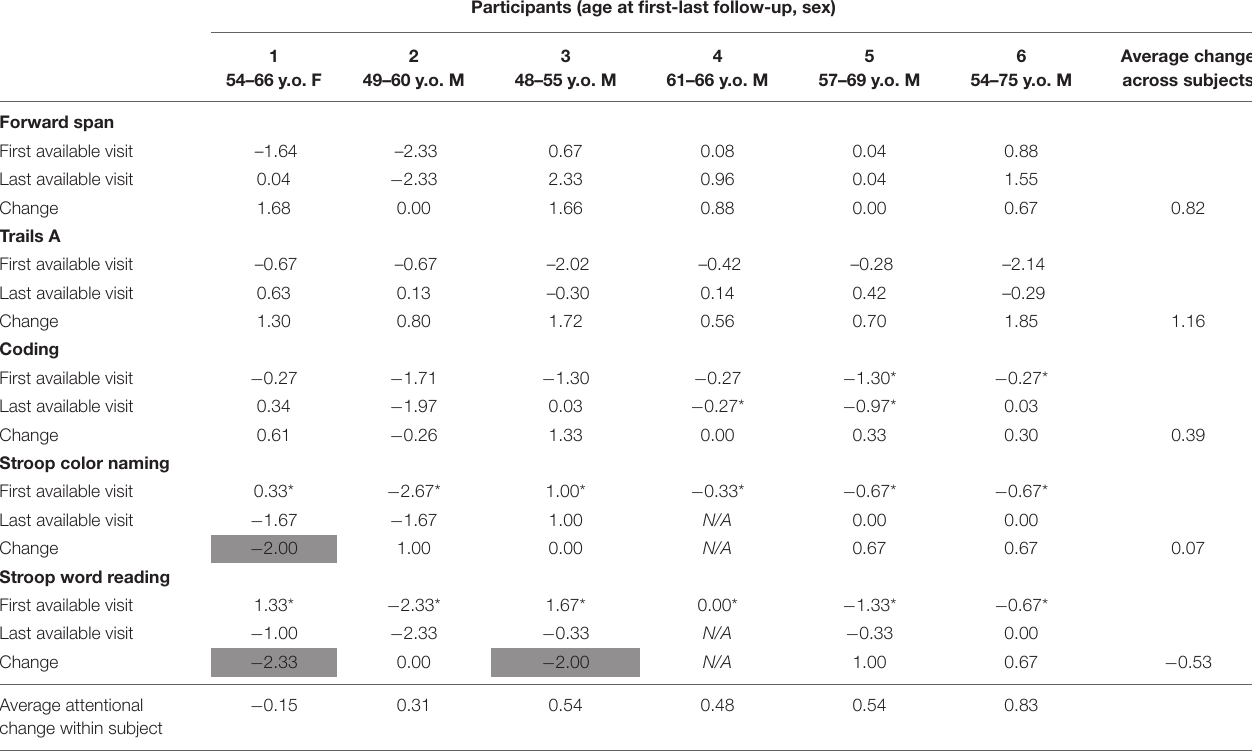
TABLE 2 | Attentional performance of the